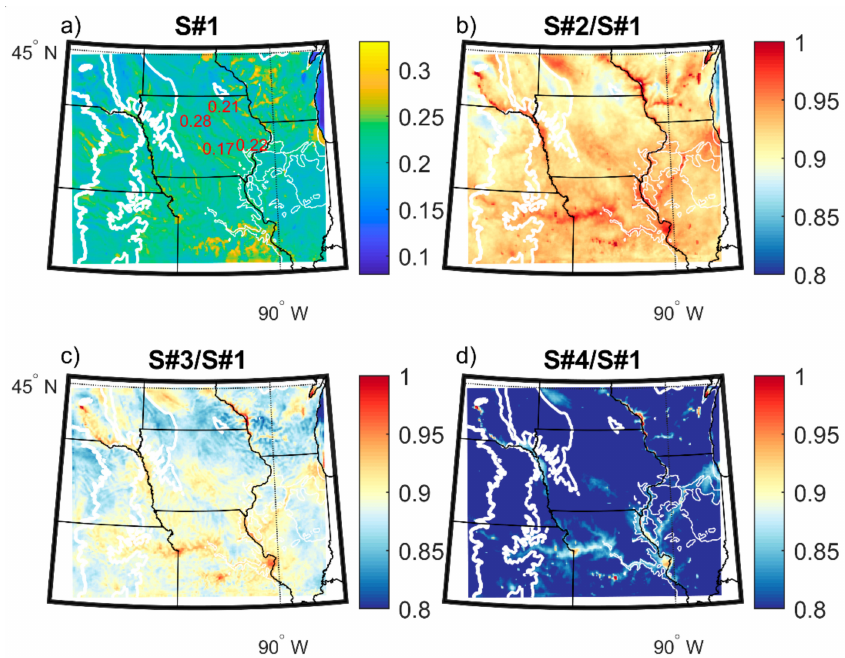
Figure 7. Shear exponent α for the four WT scenarios. The top left panel shows α calculated for each grid cell for the period December 2017–August 2018 for S#1. The other panels show the ratio of the mean shear exponent for S#2, S#3 and S#4 relative to the first scenario. The color bars for panels ( b – d ) have been restricted to 0–1 to aid legibility and comparison of the four scenarios. Observationally derived estimates of annual mean shear exponent from tall towers in Iowa for December 2006–January 2009 are also shown in ( a ). These estimates are of 0.17 for Altoona, 0.22 at Homestead, 0.21 at Mason City and 0.28 at Palmer, and are shown by the red numbers in ( a ) [23]. The black lines show the state boundaries, and the white lines show terrain contours at 200 m (thinnest), 400 m and 600 m (thickest) used to denote the